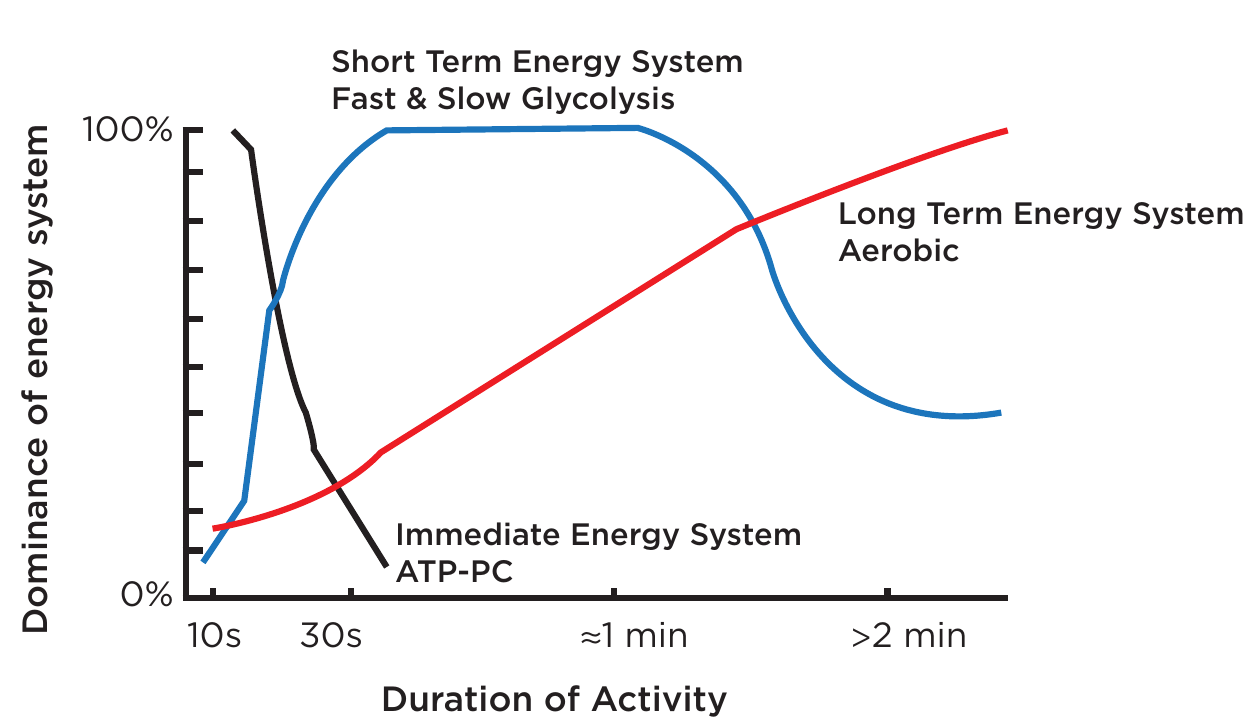
Figure 1-1. Dominant Energy System Based on Activity